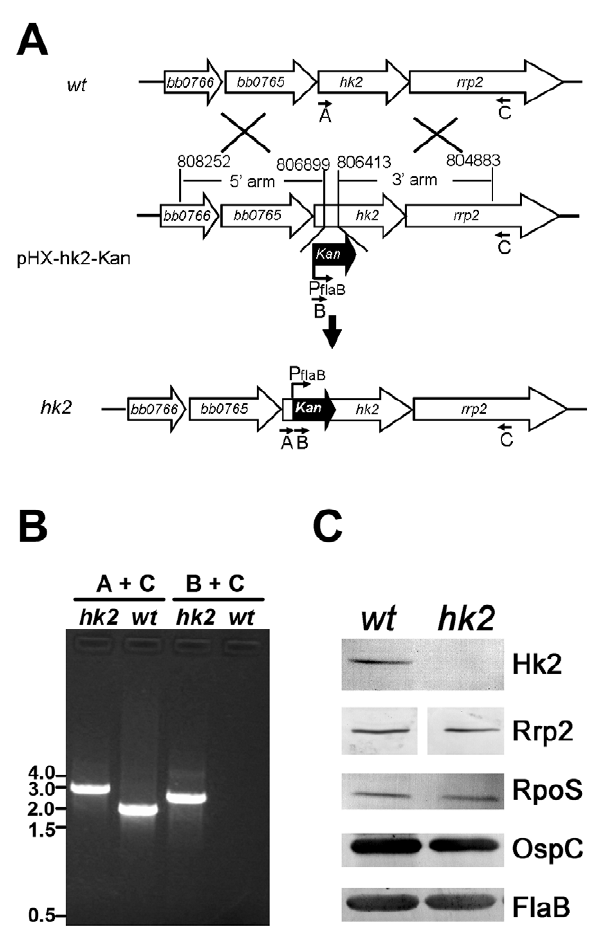
Figure 1. Construction and characterization of the hk2 mutant. ( A ) Strategy for insertional inactivation of hk2 . wt , genomic structure of hk2 and the surrounding region in wild-type B. burgdorferi . pHX-hk2- Kan, the suicide vector used for generating the hk2 mutant. Only the relevant portion of the plasmid is shown. hk2 , the diagram showing the genomic structure of the hk2 mutant. Small labeled arrows denote positions of oligonucleotide primers used for PCR analyses. ( B ) Confirmation of the hk2 mutant by PCR analyses. Letter combinations denote primer pairs used for PCR. kb: kilobase DNA ladder, wt , wild type strain; hk 2, hk2 mutant. ( C ) Immunoblot analyses of the hk2 mutant. Cultures were grown at 35 u C to late logarithmic phase (5 6 10 7 spir- ochetes/ml) and subjected to immunoblotting with monoclonal antibodies against Hk2, Rrp2, RpoS, OspC or FlaB (loading control).